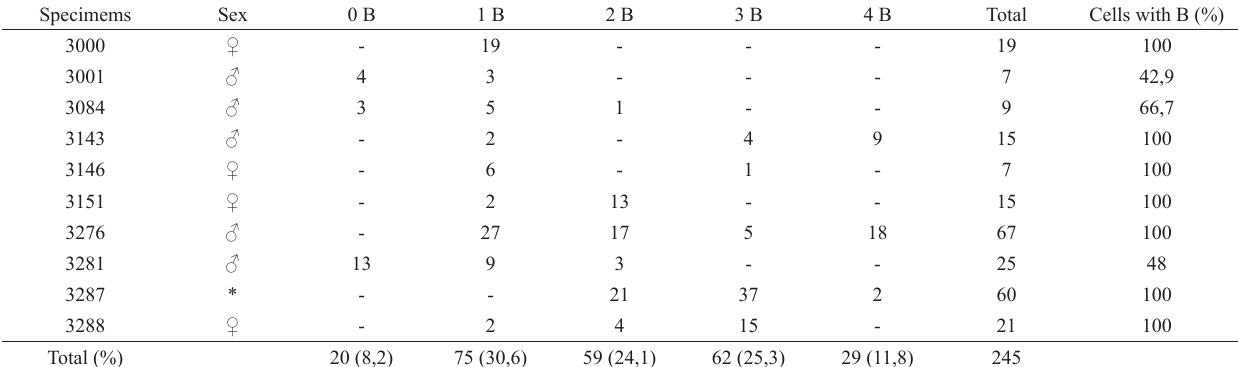
Fig. 4. C-banded metaphase of Pimelodus ortmanni . Arrows indicate the heterochromatic B chromosomes. Scales bar = 10 μm. Tab. 4. Frequency of B chromosomes in Pimelodus ortmanni from the Iguaçu River.